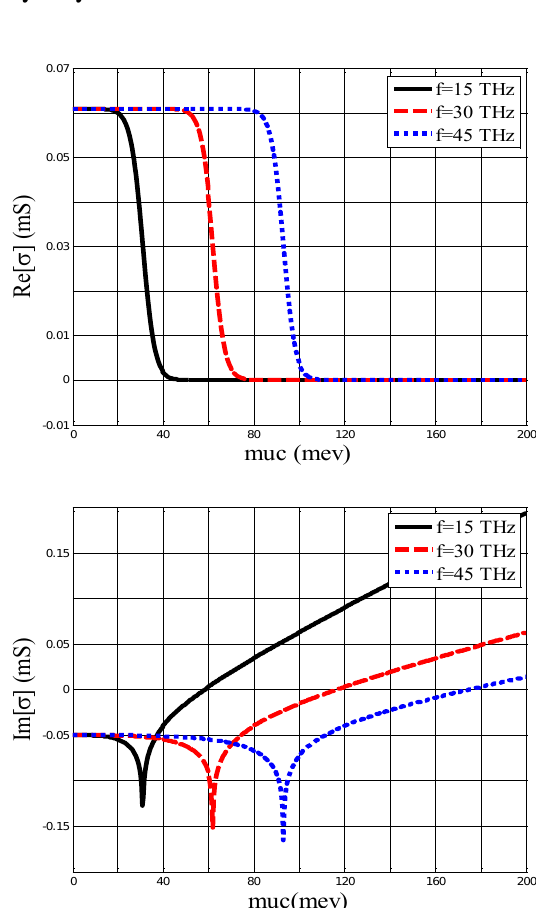
Figure 3: Optical conductivity of graphene versus voltage. The top picture shows the real part of conductivity and the bottom picture shows the imaginary part of conductivity versus chemical potential for three value of frequency.